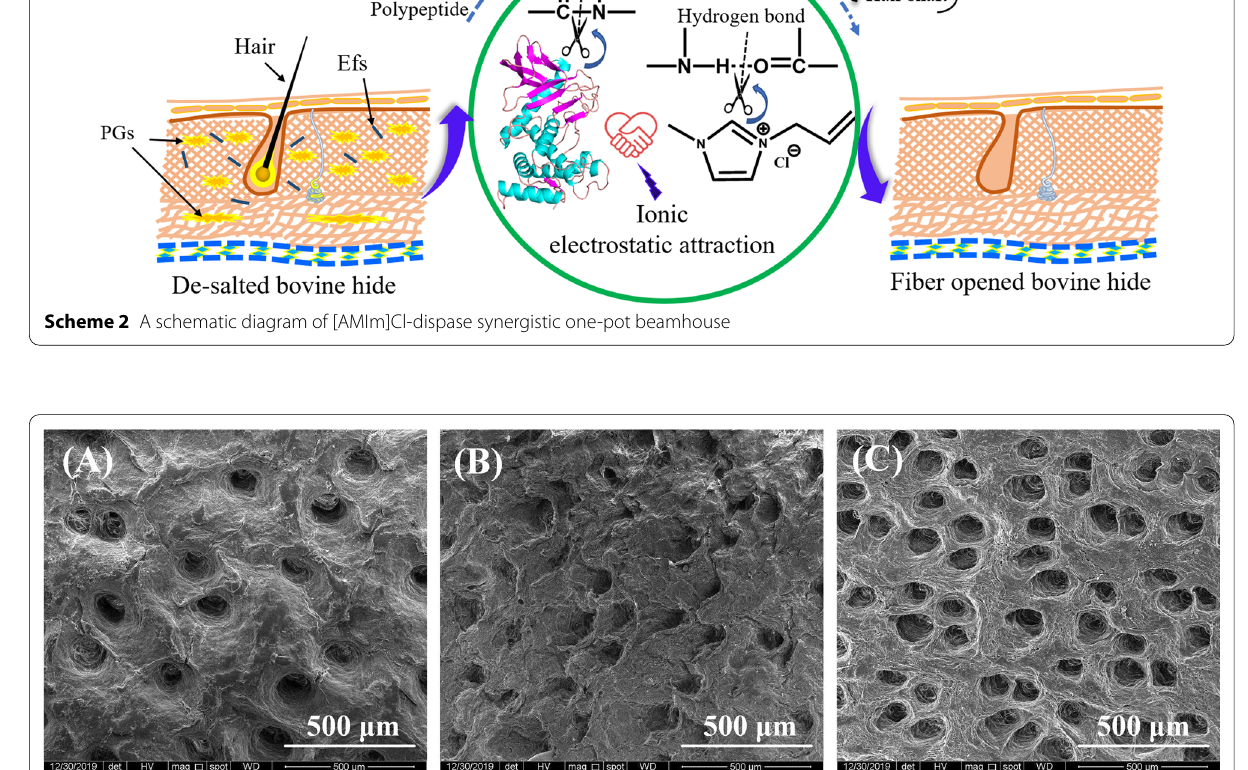
Table 1 Physical properties and hydrothermal stability of tanned leathers from conventional (C), KCl-dispase (KCl/D) and [AMIm] Cl-dispase ([AMIm]Cl/D) processes